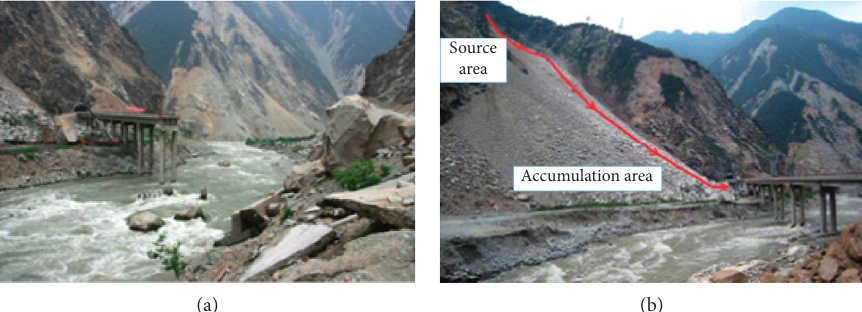
Figure 2: Rockfalls smashed up the bridge: (a) rockfalls smashed Chediguan bridge; (b) the 2nd time rockfalls smashed Chediguan bridge.